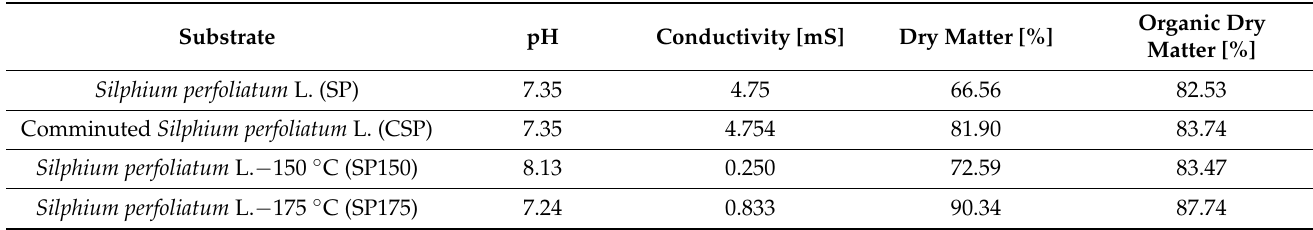
Table 6. The basic physicochemical parameters of the substrates used for testing the effect of communition and extrusion.